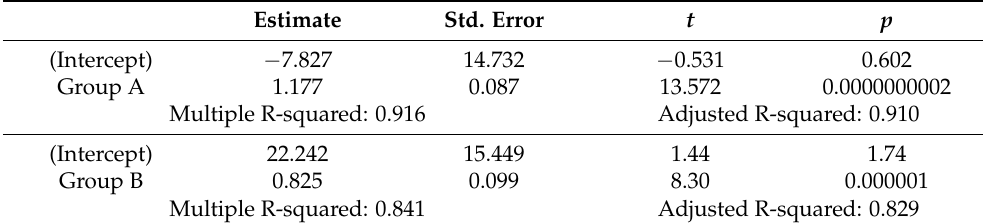
Table 4. Linear model for